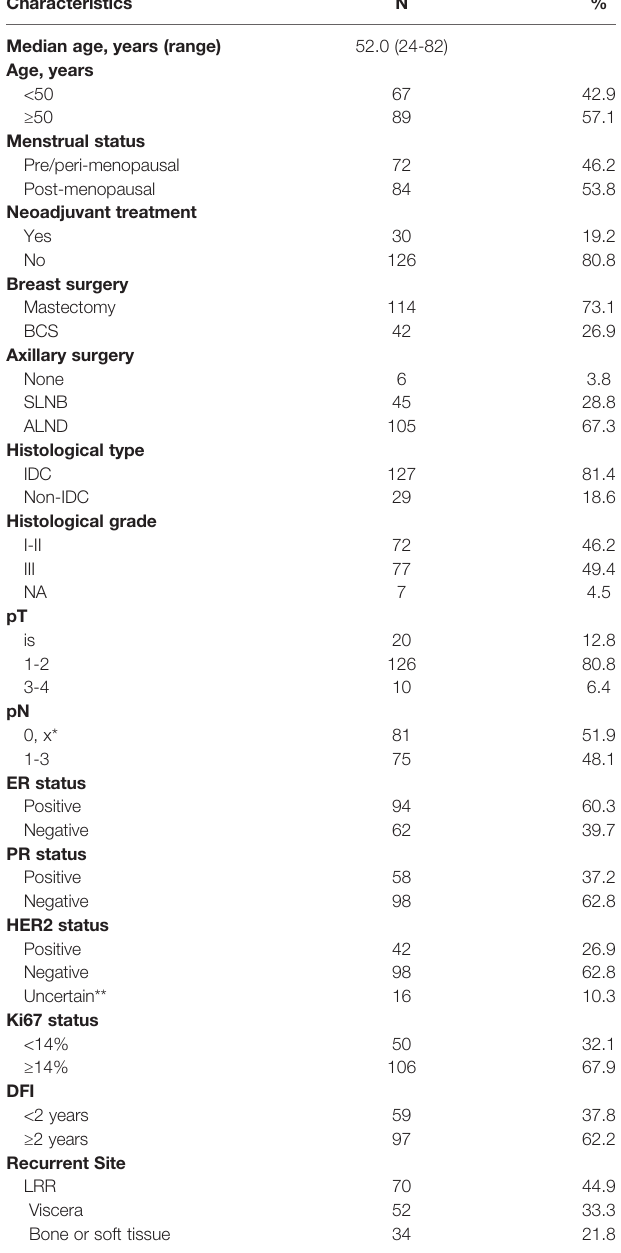
TABLE 1 | Baseline clinico-pathological characteristics of breast cancer